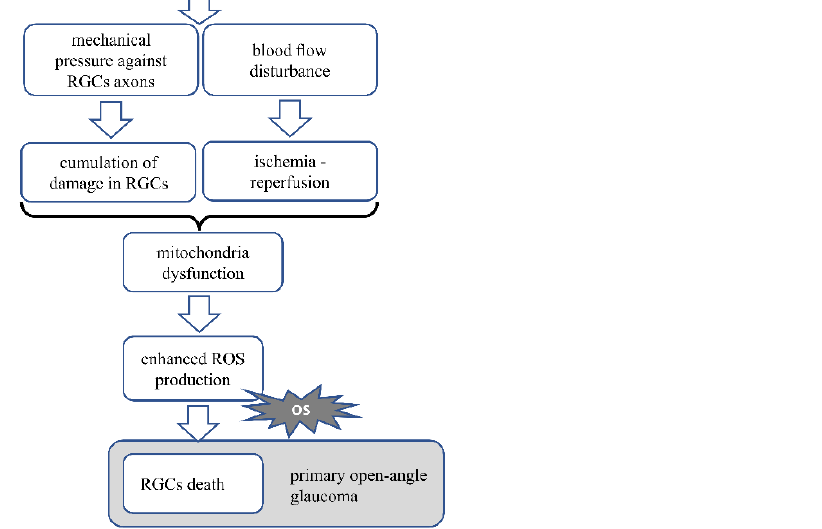
Figure 2. Presents the AMD pathomechanism and oxidative stress